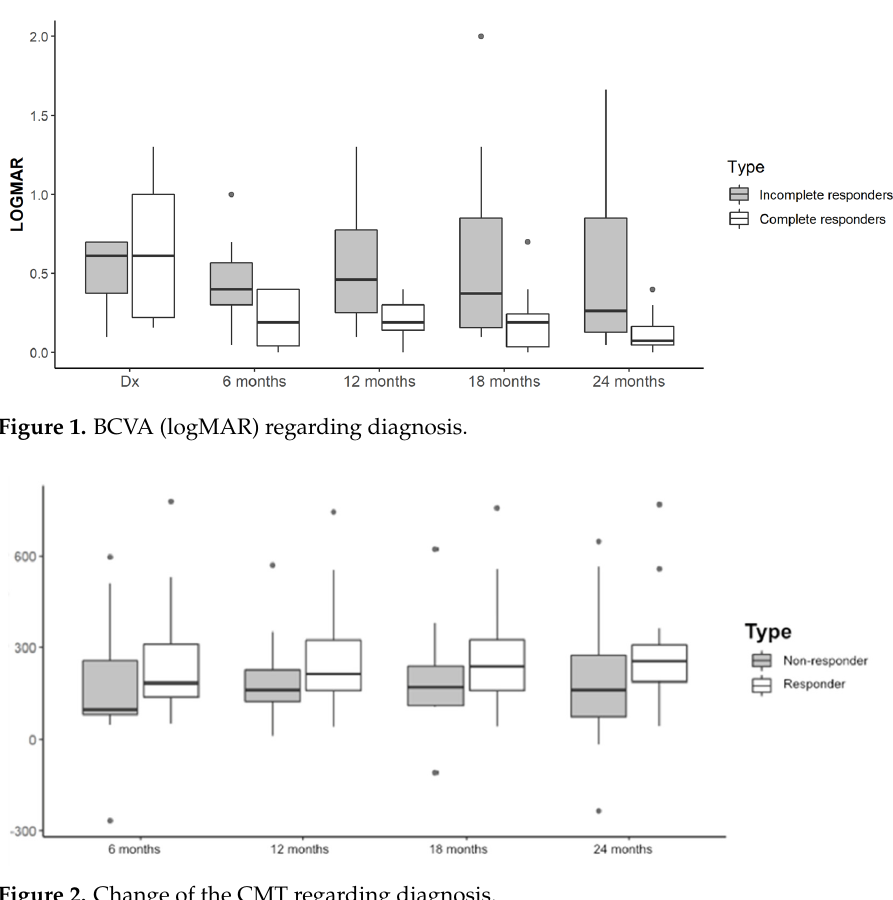
Figure 2. Change of the CMT regarding diagnosis.